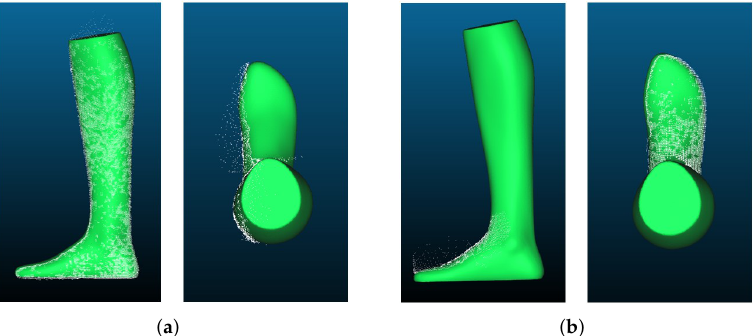
Figure 17. Point clouds recorded with Kinect Azure placed over the GT: ( a ) length reconstruction; ( b ) width reconstruction.